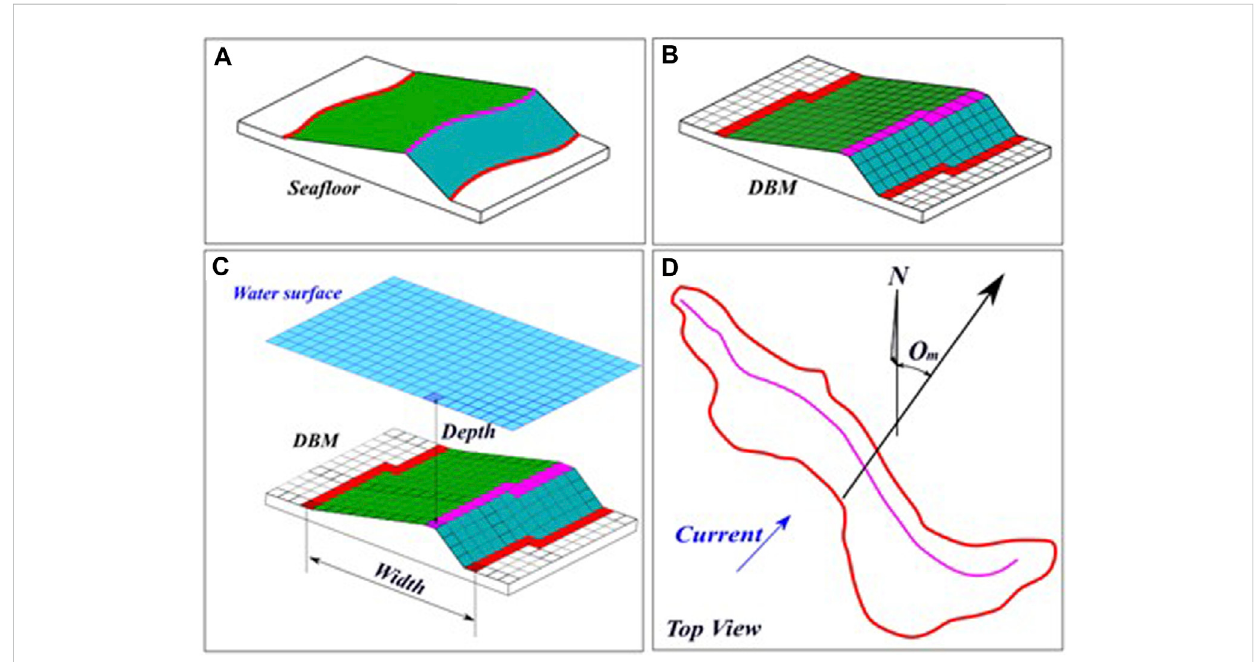
FIGURE 6 Theduneobjectsegmentedandcharacterized.In (A) ,theduneobjectonthesea fl oorwithitssalientfeatures,crestline(magenta)andtroughs(red). In (B) , the dune object is identi fi ed on the DBM grid and segmented considering the salient features. (C,D) schematize the extraction of morphological descriptors with the depth and width of the dune object [cf. (C) ] and the orientation of the underwater dune measured from the north [cf. (D) ]. Adapted from Cassol et al. (2022b). Reproduced under CC-BY-4.0.